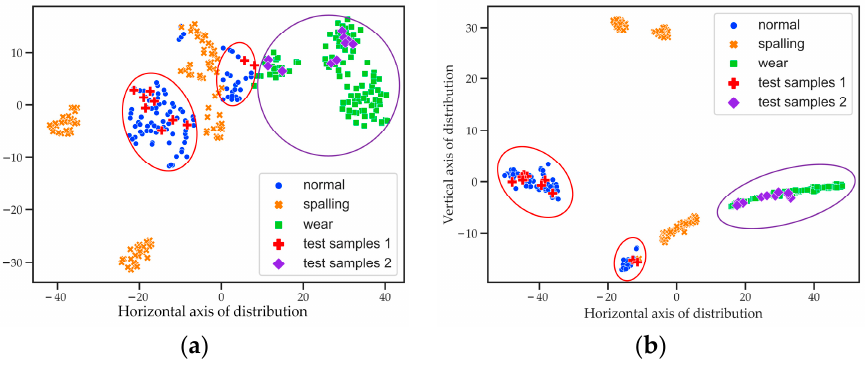
Figure 11. Visualized feature distribution of the test samples and the learning dataset; ( a ) VSDAE; ( b )